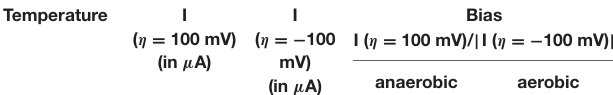
TABLE 2 | Catalytic bias data extracted from Figure 2 and Supplementary Figure 1 , for an overpotential η = ± 100 mV. Temperature